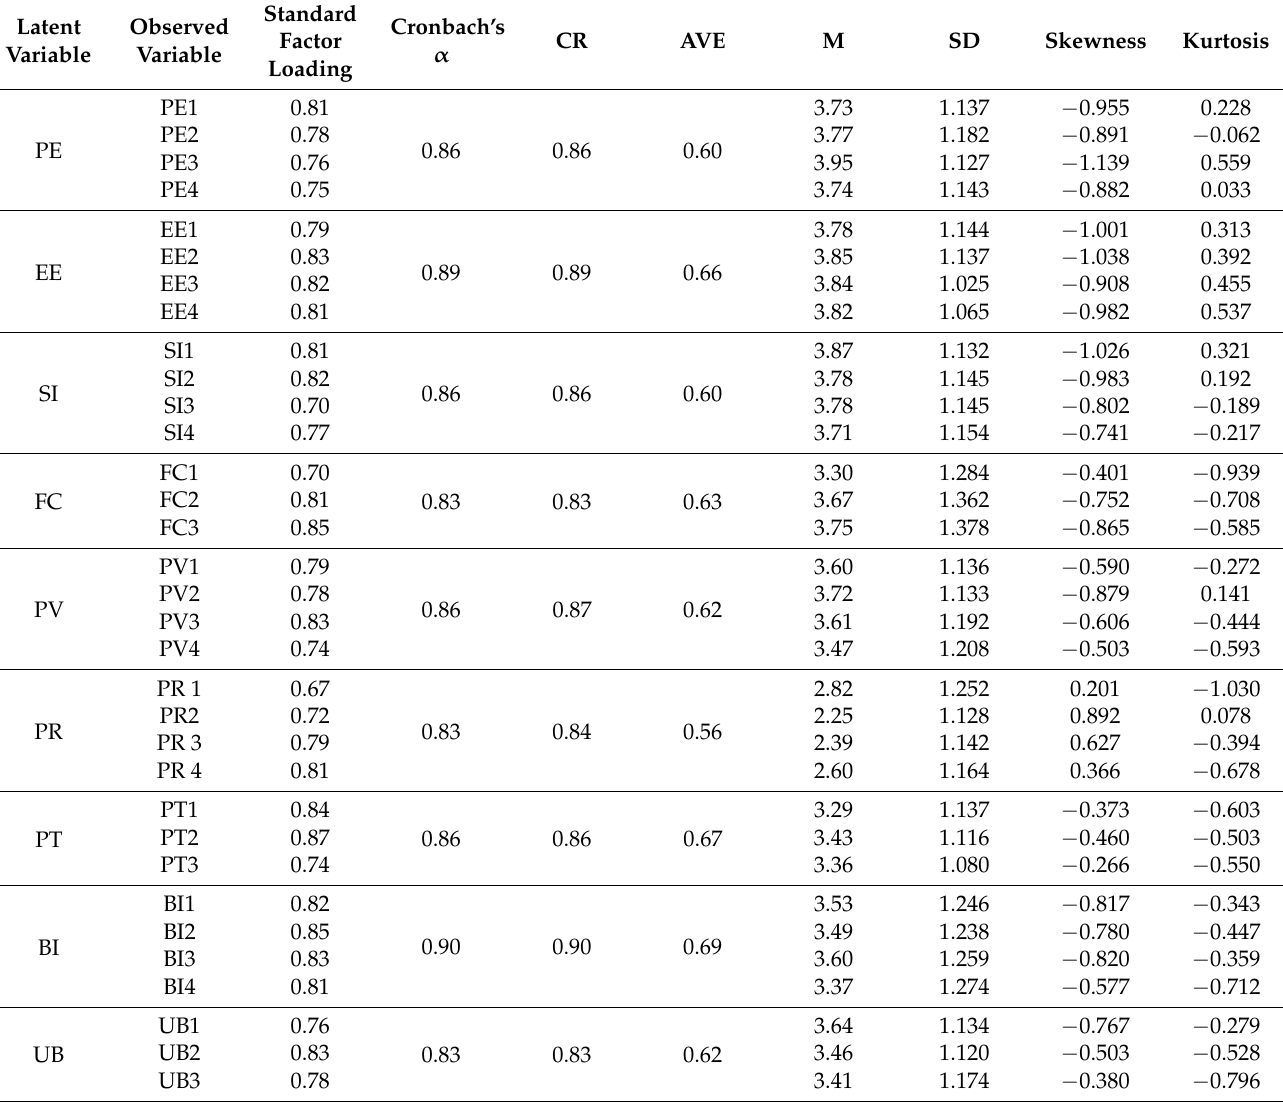
Table 7. Results of reliability and